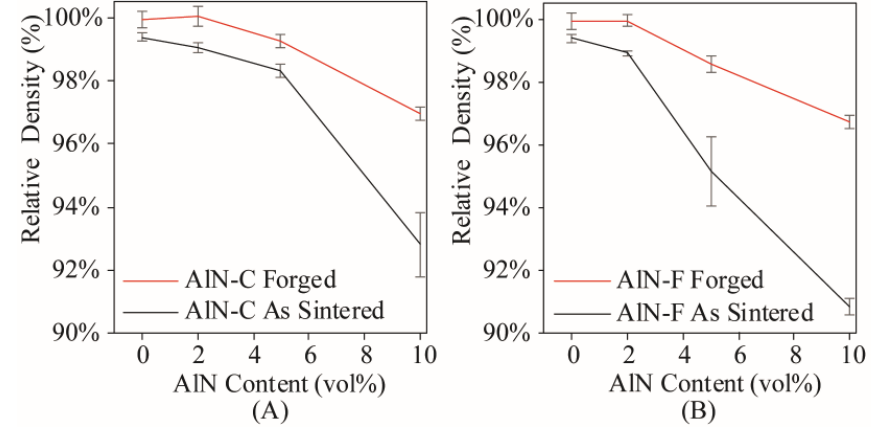
Figure 2. Densities of APM MMCs as measured before and after TMP. Materials prepared with ( A ) coarse and ( B ) fine AlN